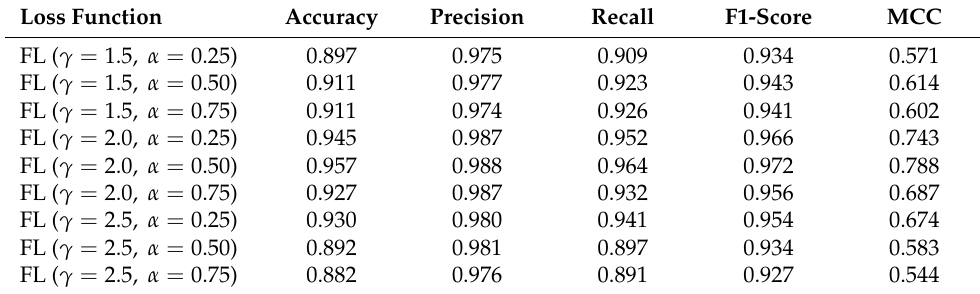
Table 8. Classification results with PCA-9 dataset for varying cost functions and respective parameter sets. (patch size parameter S = 100, 3D convolutions, see Figure A2 for network